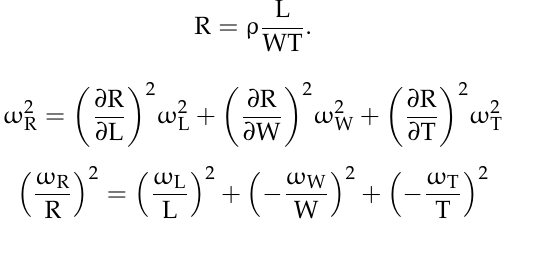
Table 2. Uncertainty Values and Corresponding